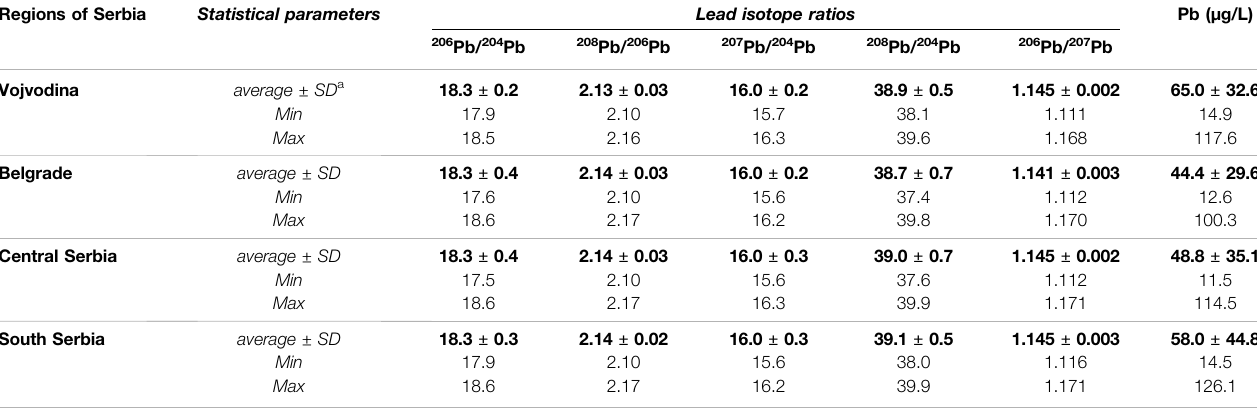
TABLE 2 | Pb isotopic composition and Pb content in red wines from four Serbian regions. Regions of Serbia